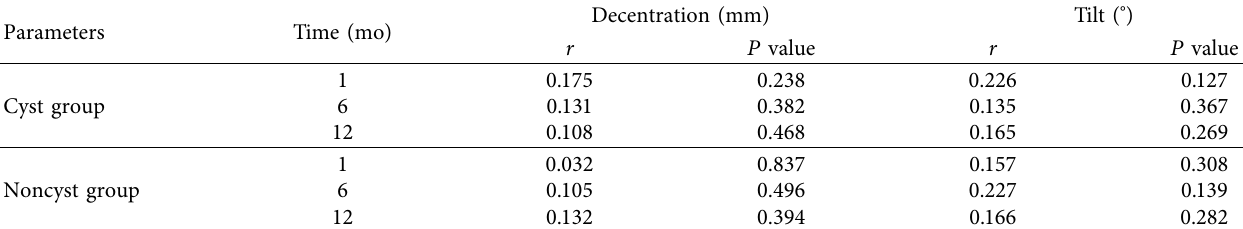
Table 2: Simple correlation coefcients for the degrees of the ICL decentration, tilt, and CDVA.